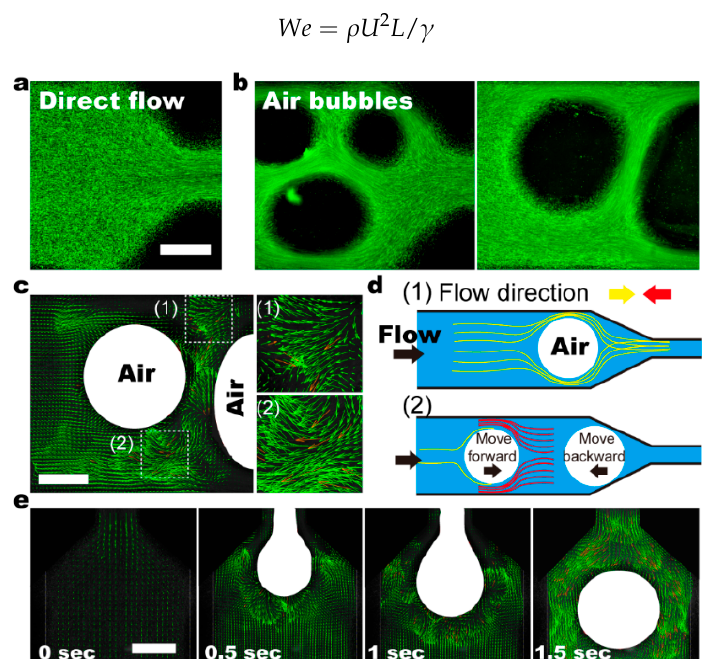
Figure 4. ( a , b ) Flow profile within the fluidic channels using air-bubbles (dark-circles) as the stirrer. Fluorescent particles of ≈ 1 mm in diameter are used as a flow tracer. ( c ) The flow profile around two air bubbles suggests turbulent flow and mass fluid transportation. ( d ) Schematic shows the mechanism of air bubbles working as the stirrer. (1) In the left panel, the existence of air bubble changes the channel cross-sectional area, and thus induces strong shear around the bubble. (2) The movement of air bubbles can be stopped by changed constriction geometry along the way. Meanwhile, the motion of the following bubbles remains, which changes the relative positions between neighboring bubbles. Consequently, liquid volume redistribution causes turbulent flow, and thus, fast mixing. ( e ) Time series showing the turbulent flow generated when an air bubble moves out from a narrow channel. Scale bars denote 500 µ m in all figures.